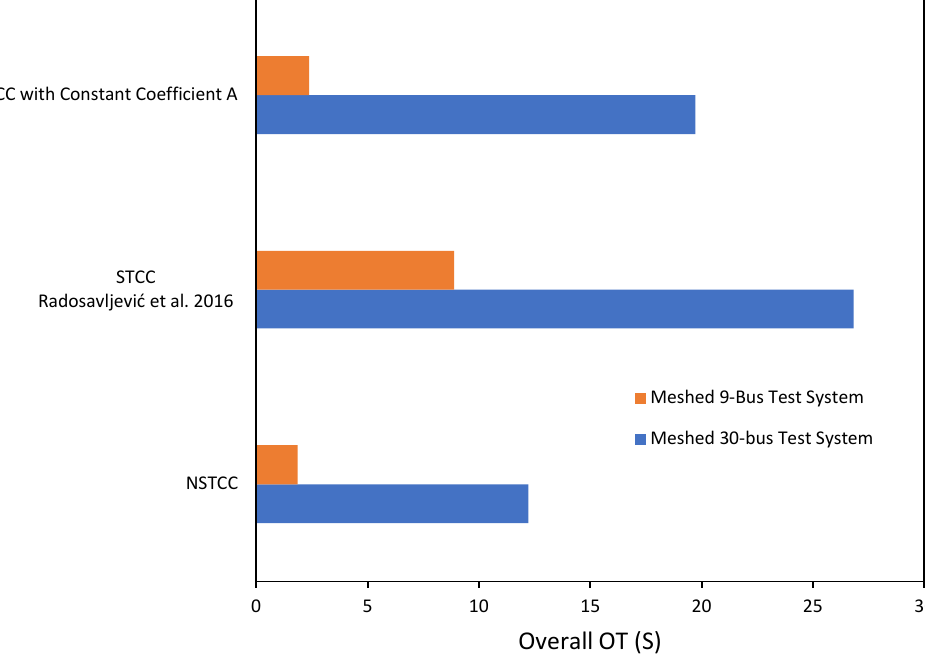
Figure 15. The overall OT in NSTCC with constant coefficient A, STCC by Radosavljević et al. 2016 [8], and NSTCC for the meshed 9- and 30-bus MGs.